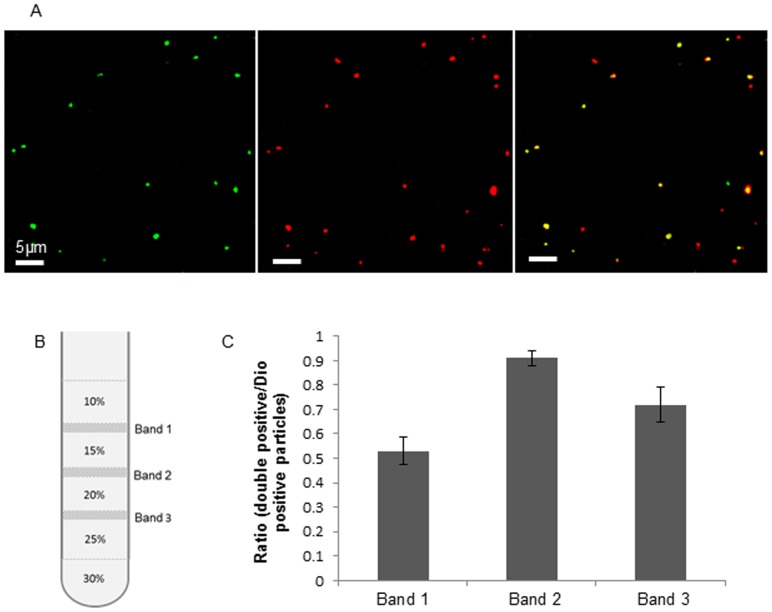
Purity of SIV determined by Dio labeling and immunofluorescence staining.(A) Confocal microscopy of the double staining of the virus preparations. Green represents Dio labeled particles; viral antigens are shown in red. Merged signals represent virus particles which are also labeled with Dio. (B) Bands form in the discontinuous iodixanol gradient separation. Three bands were identified, named Band 1, Band 2 and Band 3 from up downwards. (C) Ratio of double positive particles versus Dio positive particles for the particles from three different bands. Three independent experiments were performed and error bars indicate the standard deviation.